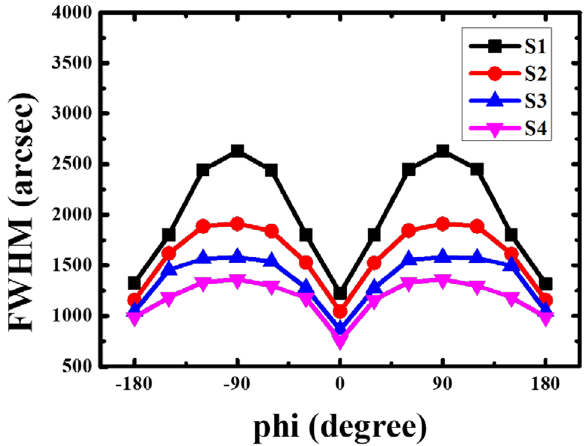
Figure 5. XRC FWHM values from on-axis (11–20) ω-scan as a function of phi angle for a -GaN grown using 0, 40, 80 and 120 pairs of SSPM-L AlN/GaN.